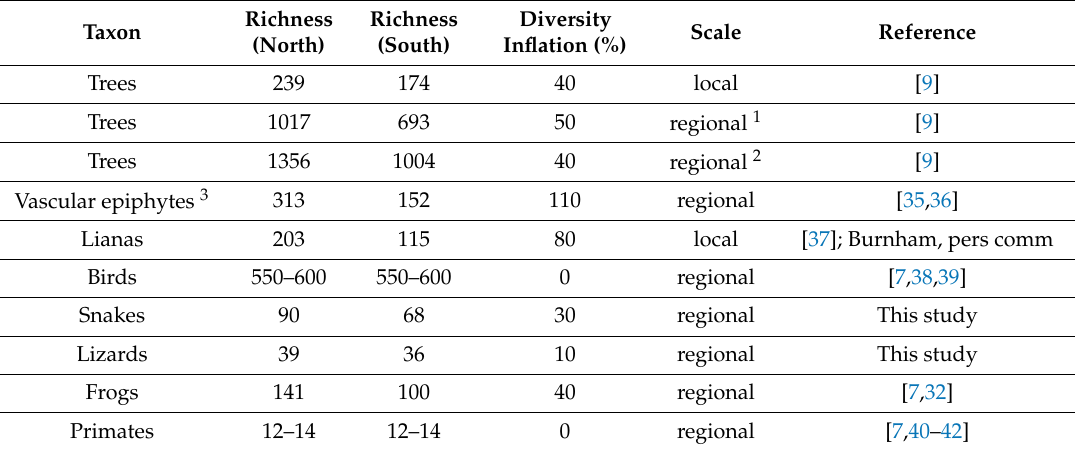
Table 2. Species richness for di ff erent taxonomic groups in lowland rainforest in the northern equatorial Amazon (Loreto, Peru; Ecuador) and the southwestern Amazon (southern Peru, northwestern Bolivia). Diversity inflation is the proportional increase in species richness at northern sites relative to southern sites. Richness Richness Diversity Scale Taxon (North) (South) Inflation (%)